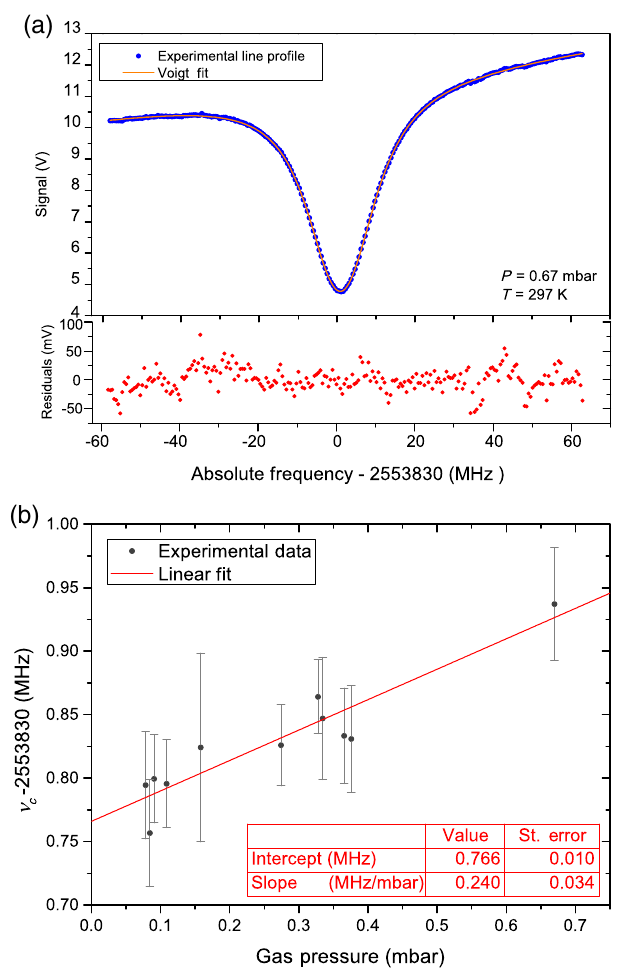
FIG. 3. The procedure for the determination of N selects a FIG. 4. (a) Experimental absorption profile (blue dots) and group of a few tens of lines (within a 10-GHz-wide window — Voigt function fit (red line) with residuals (red dots, bottom light yellow region) where one may look for the detected line. panel), for the most intense of the two lines investigated. The flat This line is the only one (blue arrow) whose listed frequency can residuals confirm that the adopted fitting function [Voigt profile be retrieved, at the sub-MHz level, by Eq. (1) with the with linear background; see Eq. (4)] well reproduces the experimental f and f values and an integer value of N experimental line shape. Gas pressure and temperature during b rep (see the Supplemental Material [24]). The presence of the pair the acquisition are also reported. (b) Dependence of the center- provides a further confirmation. It is worth noting that a line frequency on gas pressure (black dots), with the correspond- preliminary measurement of the QCL frequency, provided by ing linear fit (red line). The intercept and the slope values of the fit a FTIR spectrometer (dashed green curve), actually excludes the give the absolute frequency ( ν ) and the pressure shift of the c 0 right considered